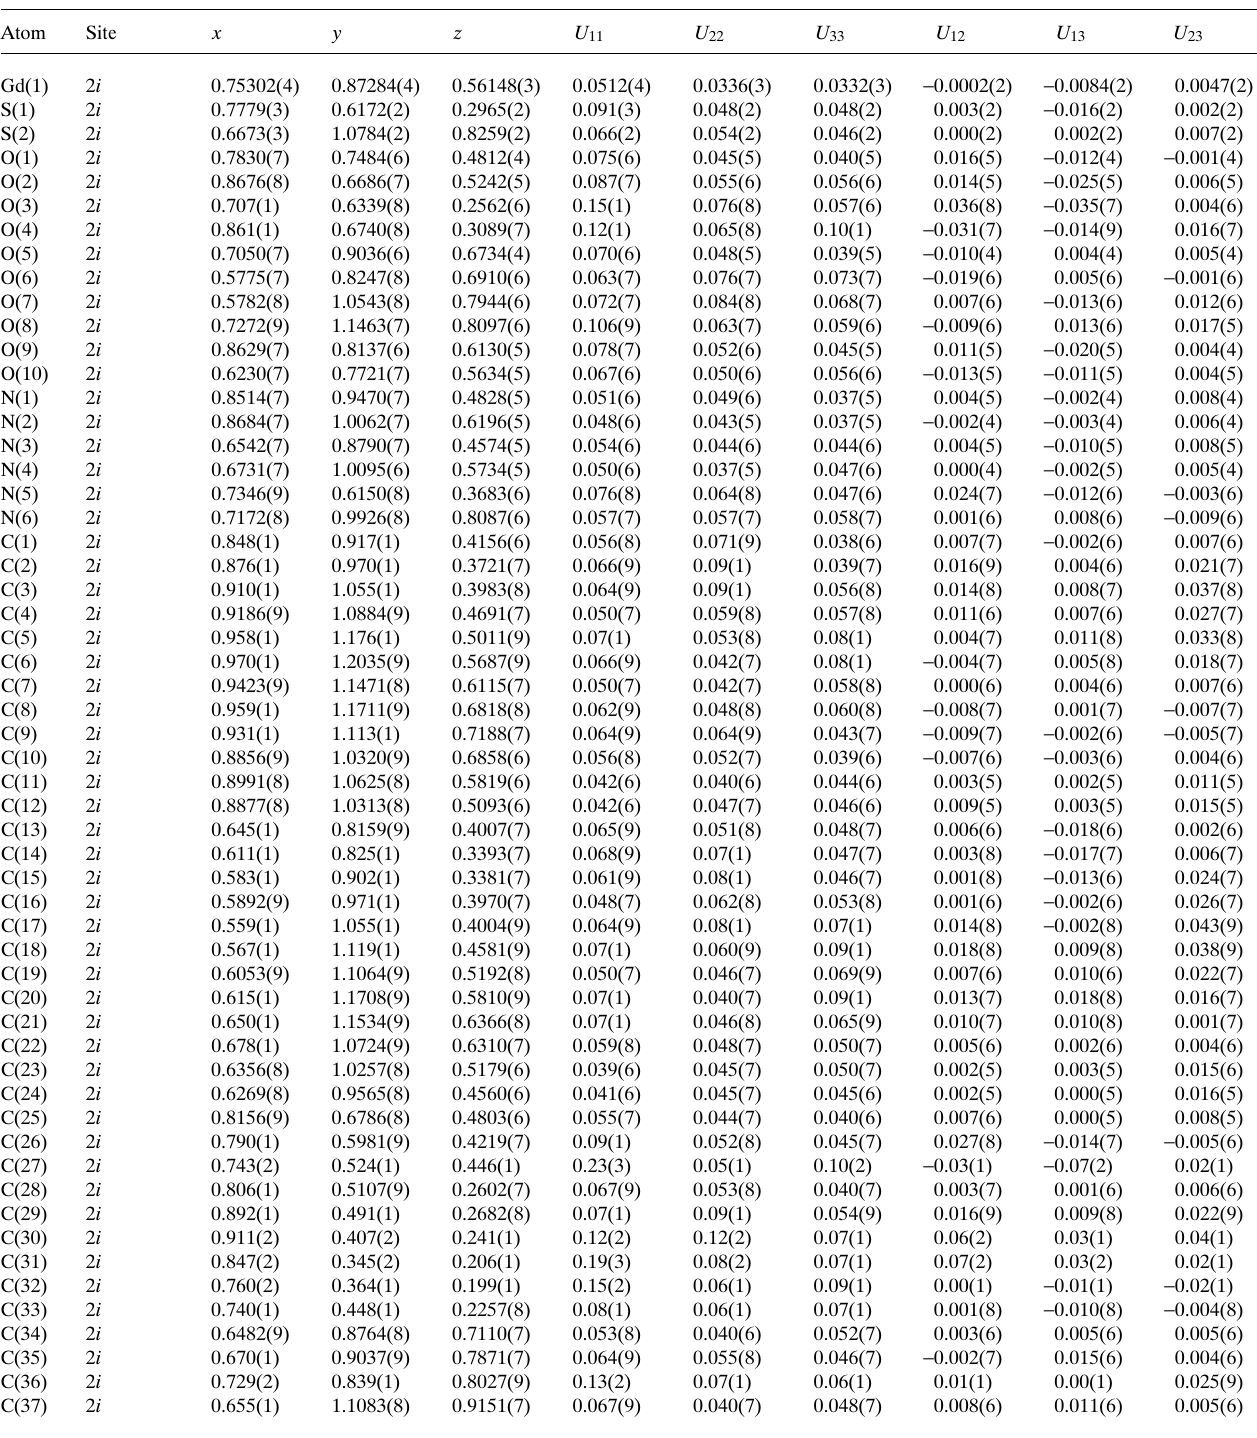
Table 3. Atomic coordinates and displacement parameters (in Å 2 )